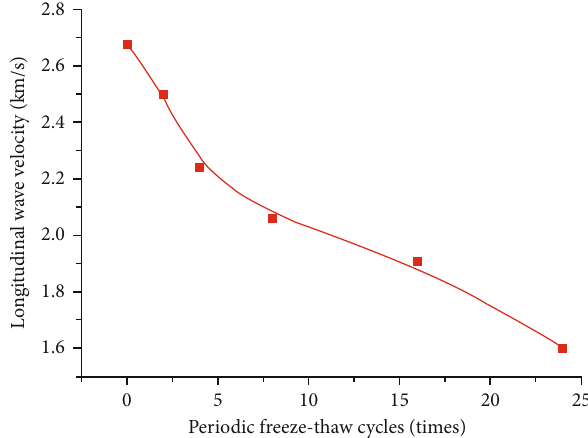
Figure 12: Longitudinal wave velocity of oil shale sample varies with periodic freeze-thaw